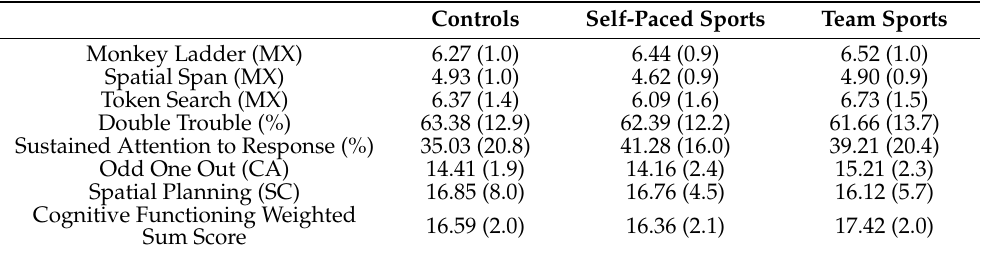
MX = maximum recall, % = percent correct responses, CA = correct attempts, SC =